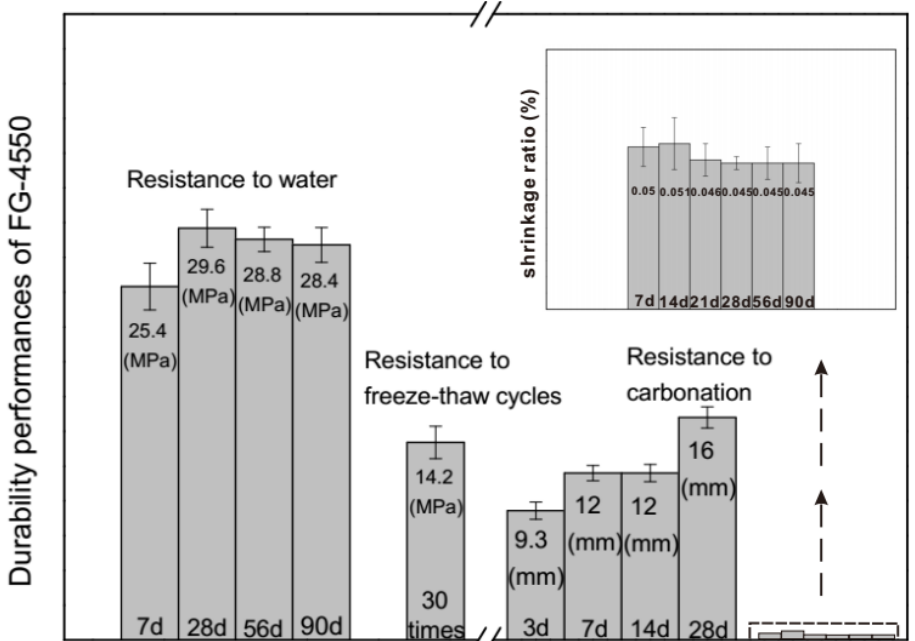
Figure 5. Durability performances of FG‐4550 under steam curing conditions.